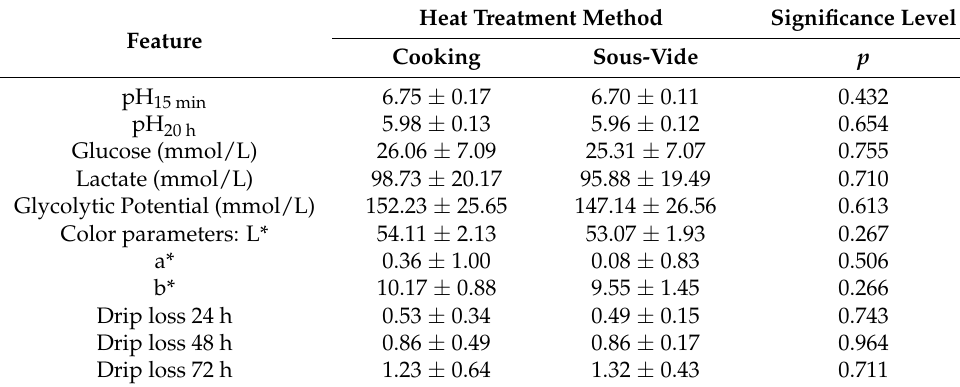
Table 2. Quality characteristics of raw meat samples (n = 20).